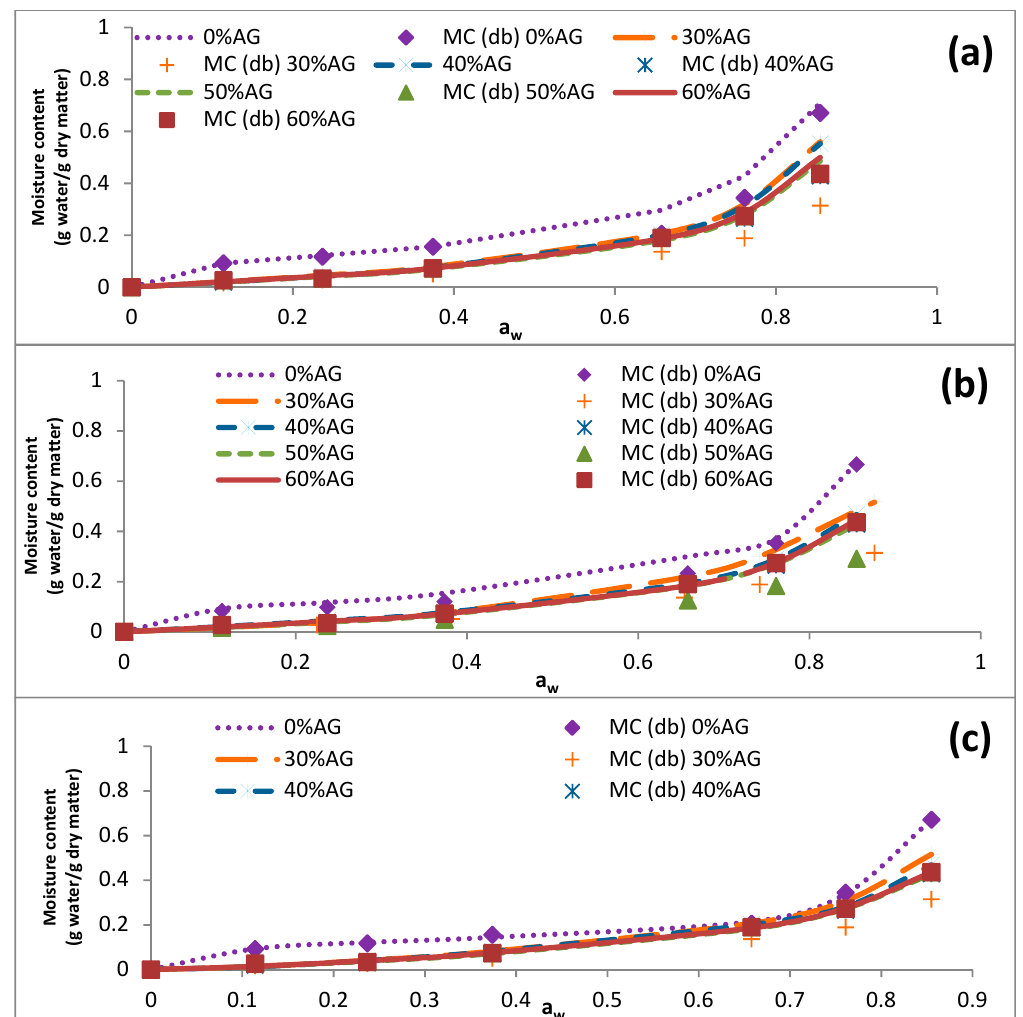
Figure 2. Effects of acacia gum concentration on the equilibrium moisture sorption isotherm of date syrup powders at 25 °C. The experimental data are presented as symbols and the data obtained by fitting the experimental data into mathematical models are presented as lines. ( a – c ) represent the obtained data from BET, GAB, and Peleg models. 0% AG: 100% DS-0% AG; 30% AG: 70% DS-30%